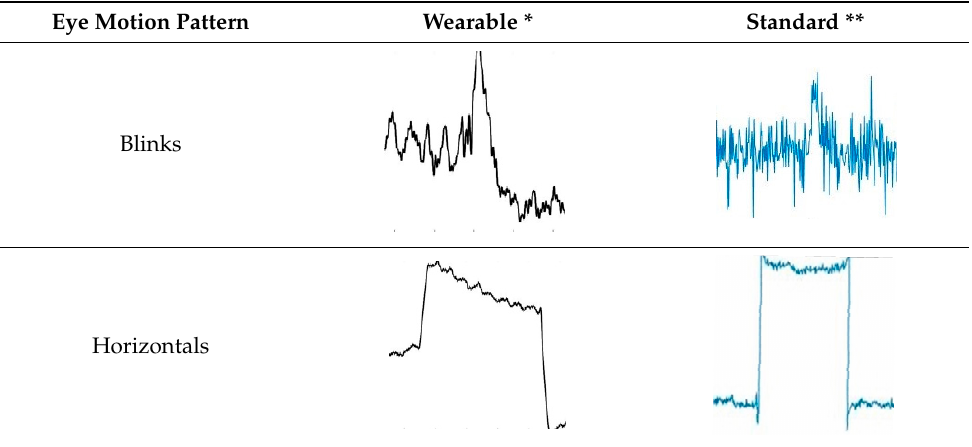
Table 4. The verification experimental results.